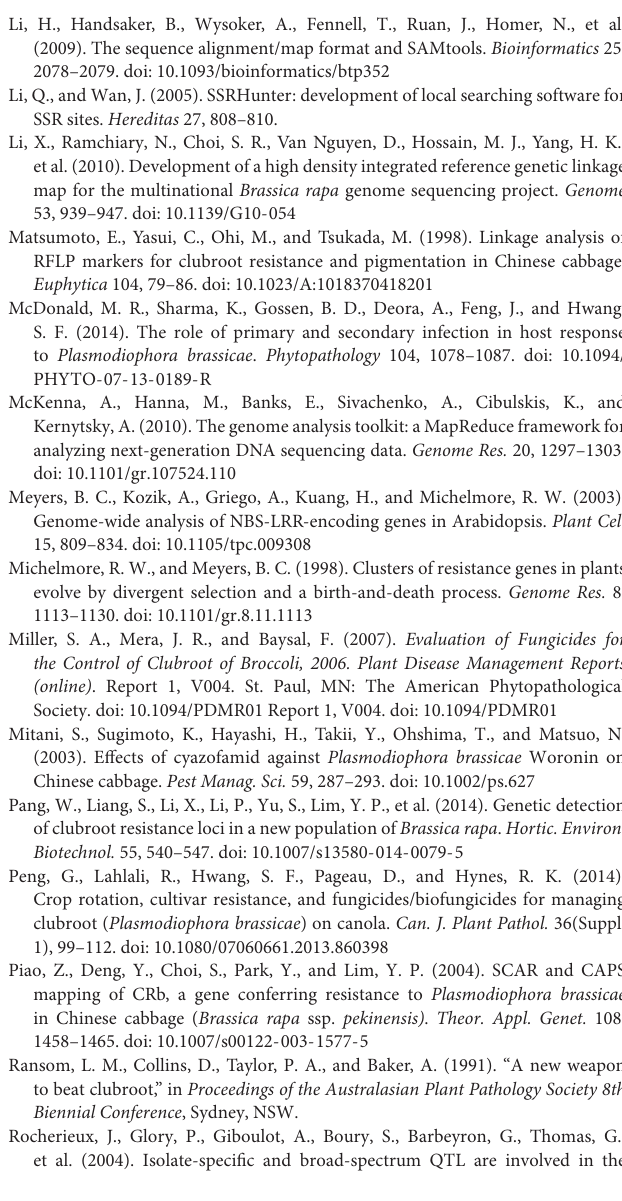
FIGURE S1 | Agarose gel of PCR product of InDels validation primer set. FIGURE S2 | Validation of CRd closely linked marker (A) yau376 and (B) yau389 using natural population. Lanes 1–25 are materials that have been listed in Supplementary Table S4 . Black arrow indicates the clubroot-resistant band. TABLE S1 | Details of SNP index and annotation for 1953 SNPs and InDels that can cause changes in the amino acid sequence of the candidate region. TABLE S2 | Primers designed for InDels validation and PCR product sequences. TABLE S3 | Markers used for genetic map construction in this study. TABLE S4 | Materials used for natural validation in this study. TABLE S5 | Primer set used for semi-quantitative RT-PCR